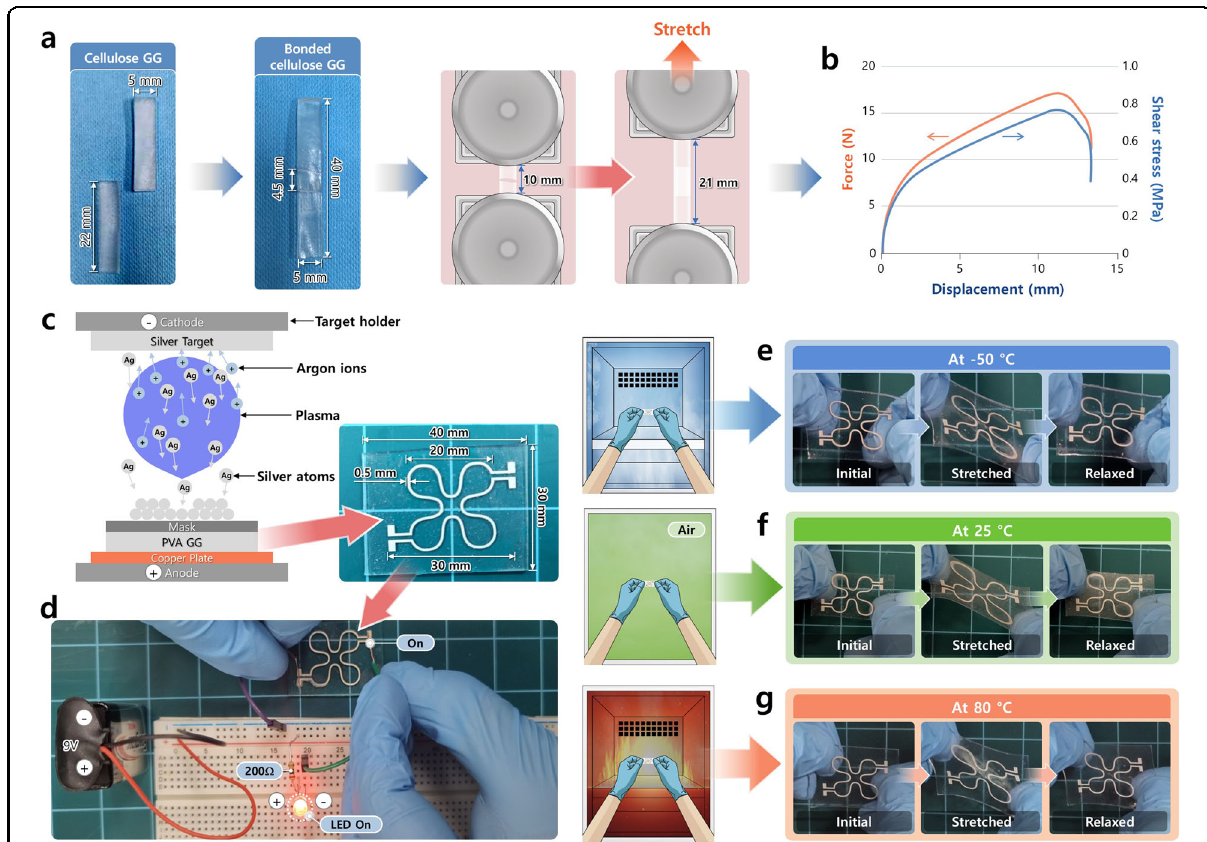
Fig. 5 GG-based self-welding and stretchable electrical pattern. a Demonstration of the self-welding process of cellulose GG. b Lap shear test result to determine the shear adhesive force and strength of the welded cellulose GG. c Illustration and photograph of the silver-patterned PVA GG fabricated by the mask-controlled ion-sputtering process. d LED switching by the patterned PVA GG connected to a 9 V battery with a 200 Ω resistor. e – g Demonstration of the stretchability of the patterned PVA GG at − 50, 25, and 80